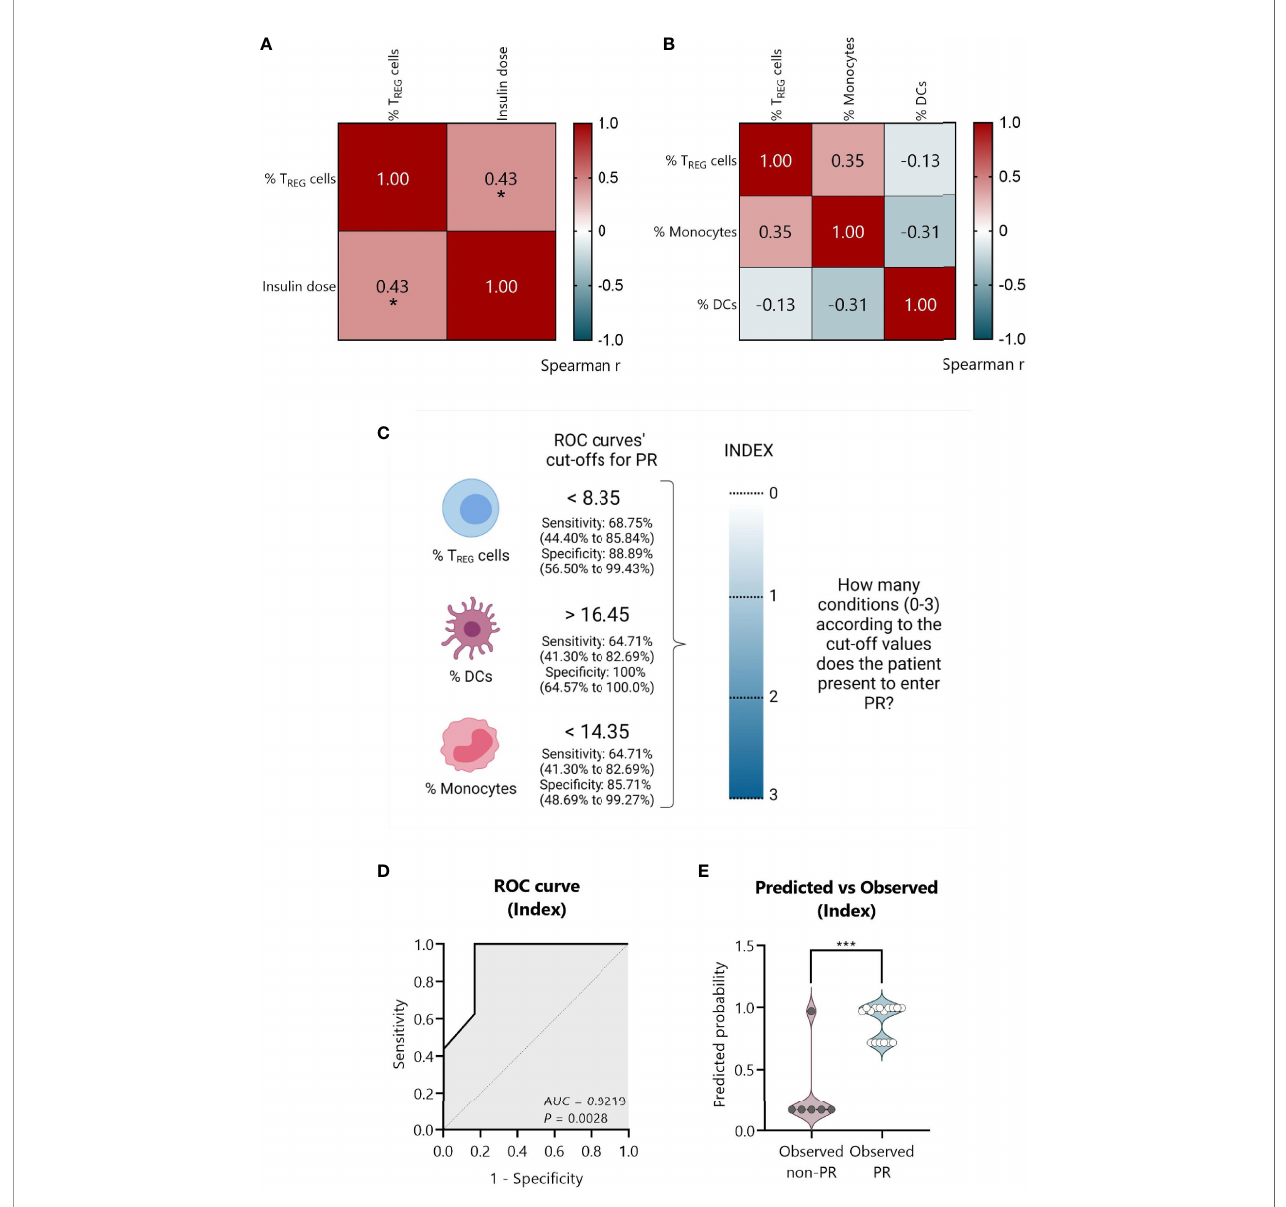
FIGURE 10 | An index-based model comprising the percentage of T REG , DCs, and monocytes could predict PR at T1D diagnosis. (A) Spearman ’ s correlation coef fi cient matrix between insulin dose and the percentage of T REG ( n = 25), and (B) between the percentages of T REG , DCs, and monocytes ( n = 22) are shown in the form of a heatmap for r values (blue; positive correlation; red, negative correlation). (C) Strategy followed to create an index comprising all the independent signi fi cant variables. From ROC curves, the best cut-off values were selected to discriminate between the remitter and the non-remitter groups for the percentage of T REG (<8.35), DCs (>16.45), and monocytes (<14.35), considering both the sensitivity and the speci fi city with 95% CI. An index including the selected cut-off ’ s values was created to determine for each patient how many conditions they met for entering PR on a 0 – 3 scale (0, no condition; 3, all conditions), being the cut-offs the conditions that should be ful fi lled. (D) Graphical representation of the AUC for the created index. (E) Violin plot showing the frequency distribution of predicted probabilities for both the observed PR ( n = 16) and non-PR ( n = 6) groups regarding the index. Each dot represents an individual patient. Violin plots show the median (thick dashed line) and fi rst and third quartiles (thin dashed lines). * P ≤ 0.05 after Spearman ’ s correlation test, *** P < 0.001 after 2-tailed Mann – Whitney test. P ≤ 0.05 is considered signi fi